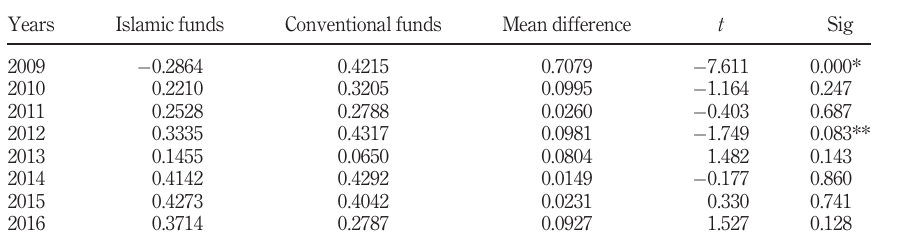
Table V. Yearly mean values of systematic risk